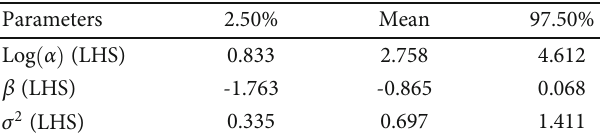
Table 3: 95% HPDIs (excluding 2010 for LHS).